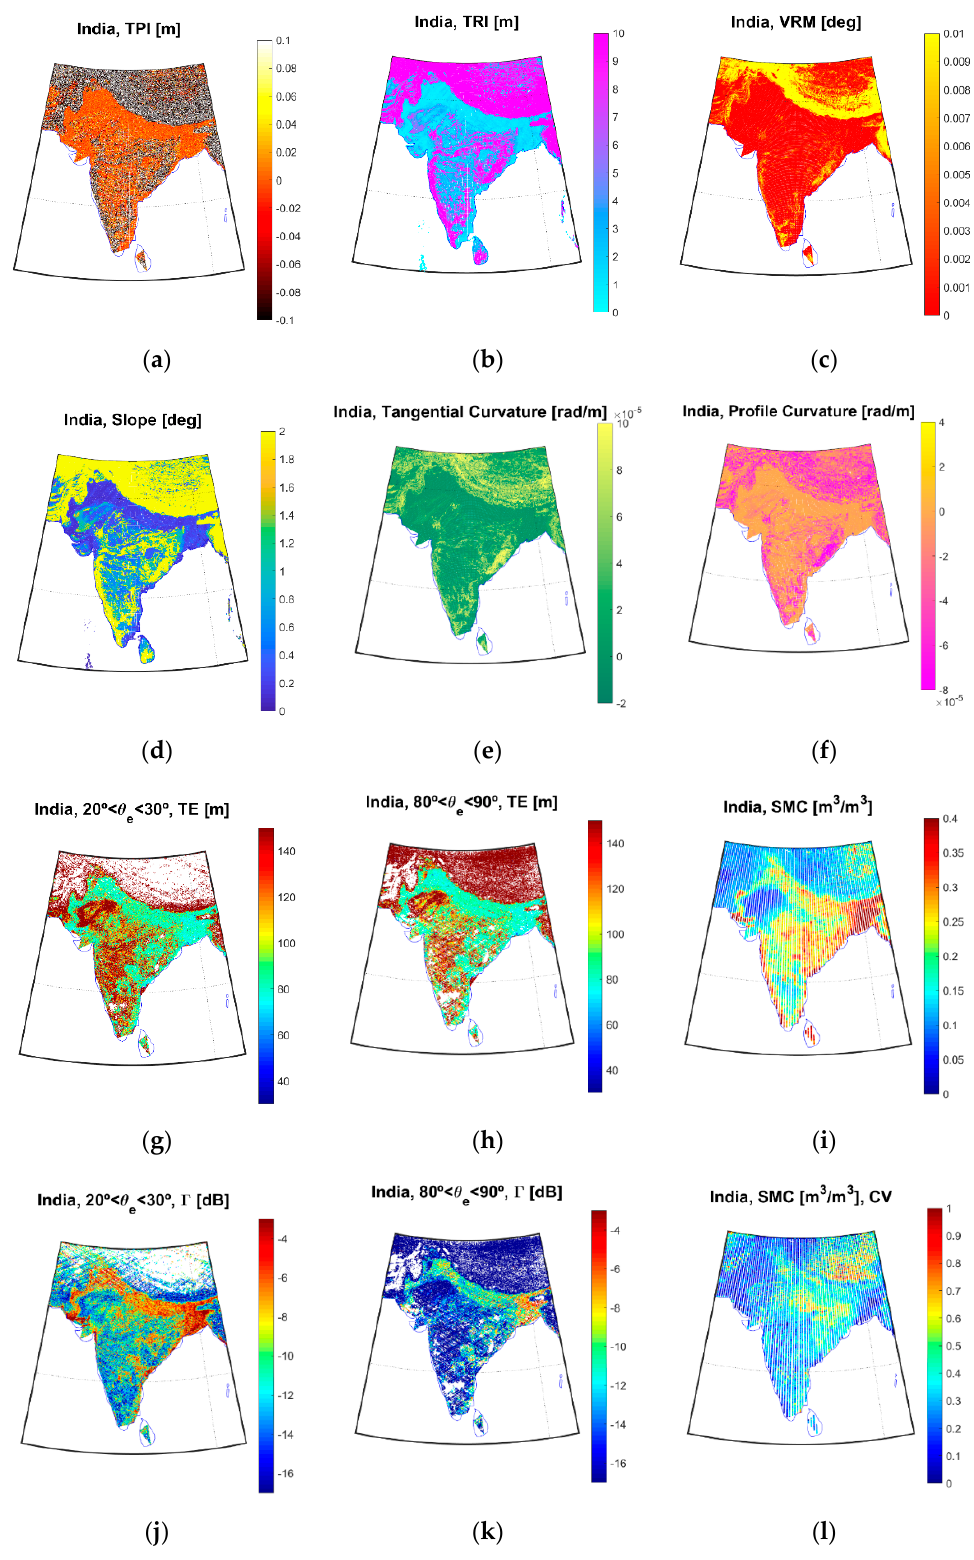
Figure 4. Regional scale study over a target area in South Asia. Different scientific observables and auxiliary data were depicted: ( a ) TPI, ( b ) TRI, ( c ) VRM, ( d ) β , ( e ) TC, ( f ) PC, ( g ) CyGNSS-derived TE at θ e ~ [20, 30] ◦ , ( h ) TE at θ e ~ [80, 90] ◦ , ( i ) SMAP-derived SMC, ( j ) CyGNSS-derived Γ at θ e ~ [20, 30] ◦ , ( k ) Γ at θ e ~ [80, 90] ◦ , and ( l ) SMC